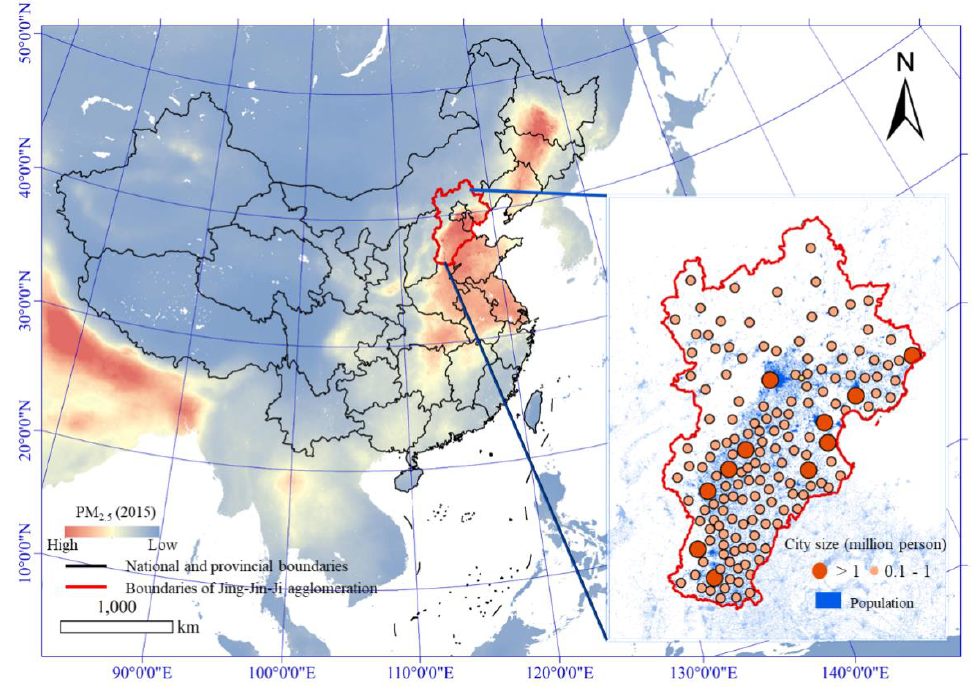
Figure 1. Geographical location, air pollution level, and population distribution of the study area.